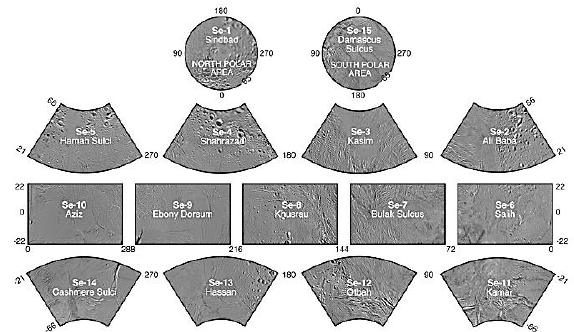
Figure 5: Quadrangle mapping scheme for Enceladus. Credit: NASA/JPL/Space Science Institute.